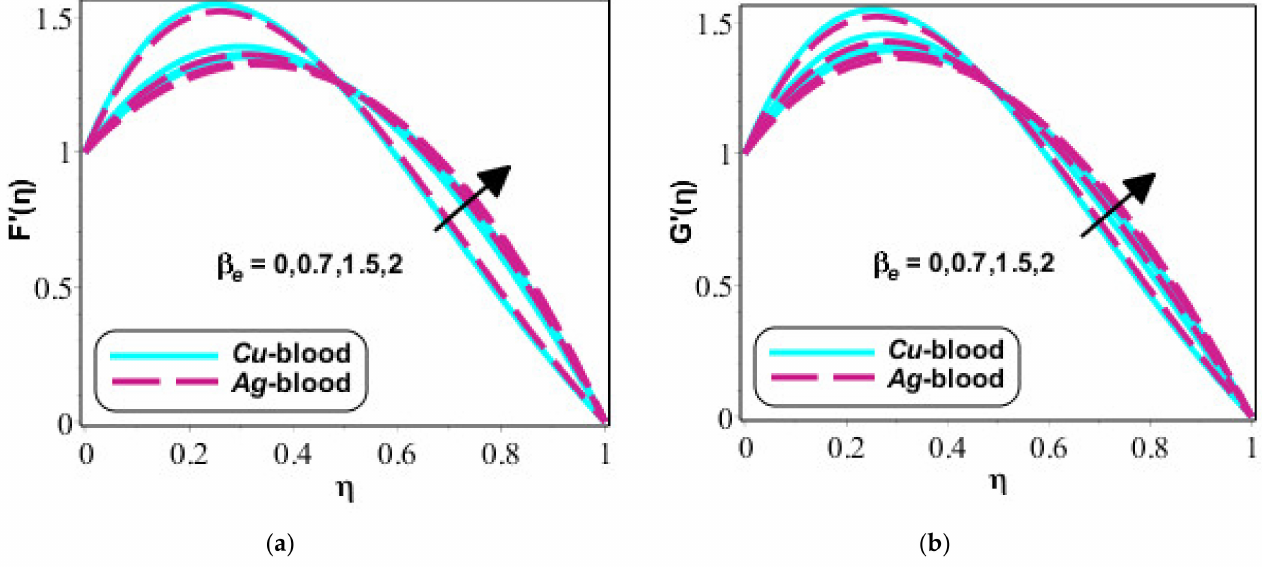
Figure 4. Behaviour of ( a ) F (cid:48) ( η ) and ( b ) G (cid:48) ( η ) as varying β e when φ = 0.1, Re = 5, β i = 1.5, λ = 2, M =